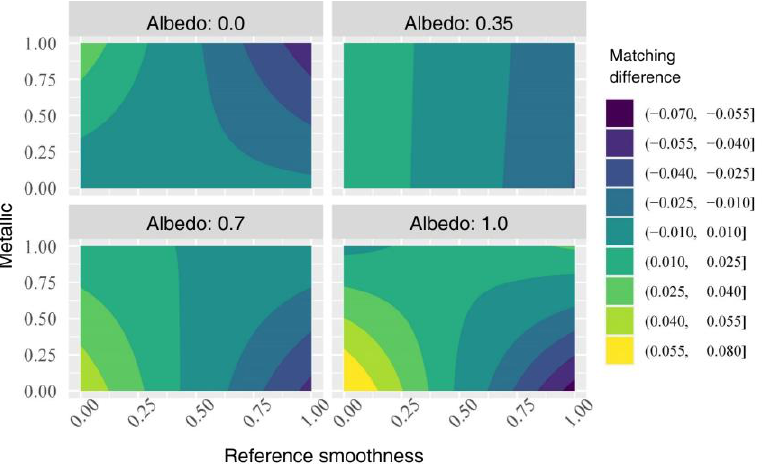
Figure 7. Contour map of glossiness perception difference.